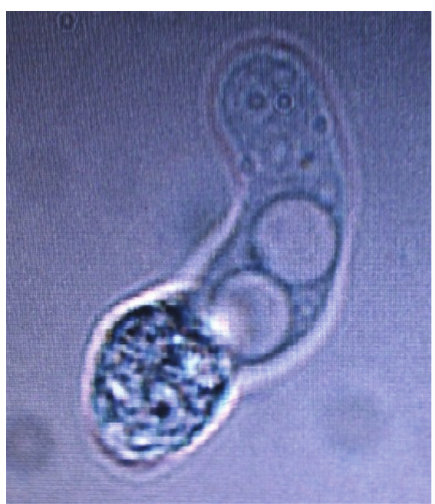
Figure 1: CSF methylene blue wet preparation showing Naegleria fowleri with granular cytoplasm and